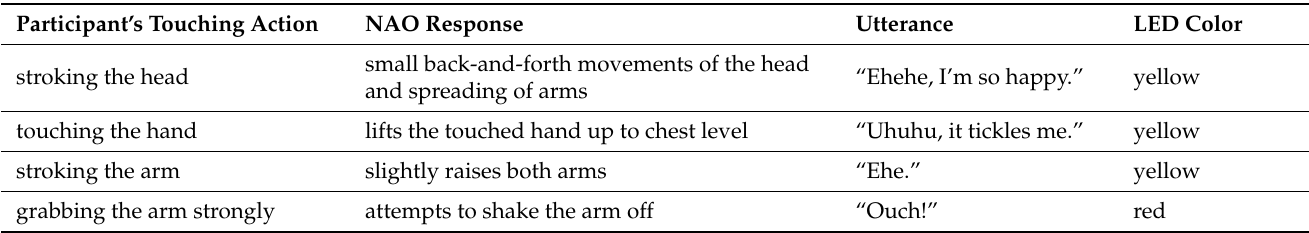
Table 1. Appropriate reactions of NAO to human